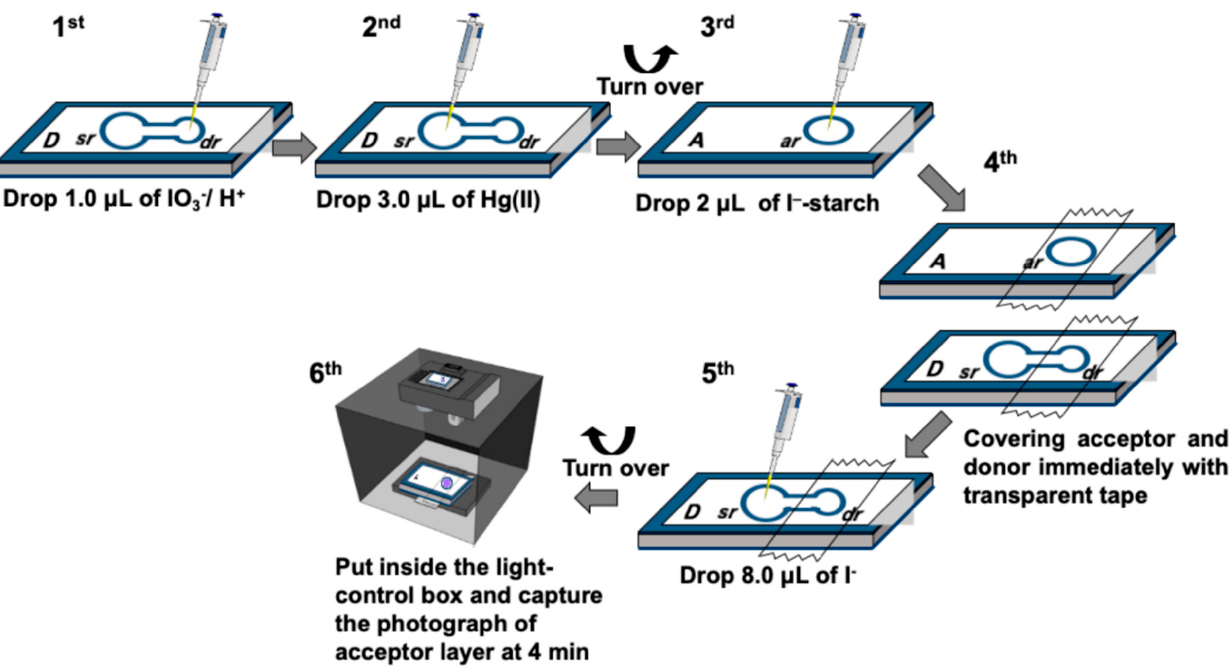
Figure 2. Illustration of the operating steps for the determination of mercury using the membraneless gas-separation µPAD .